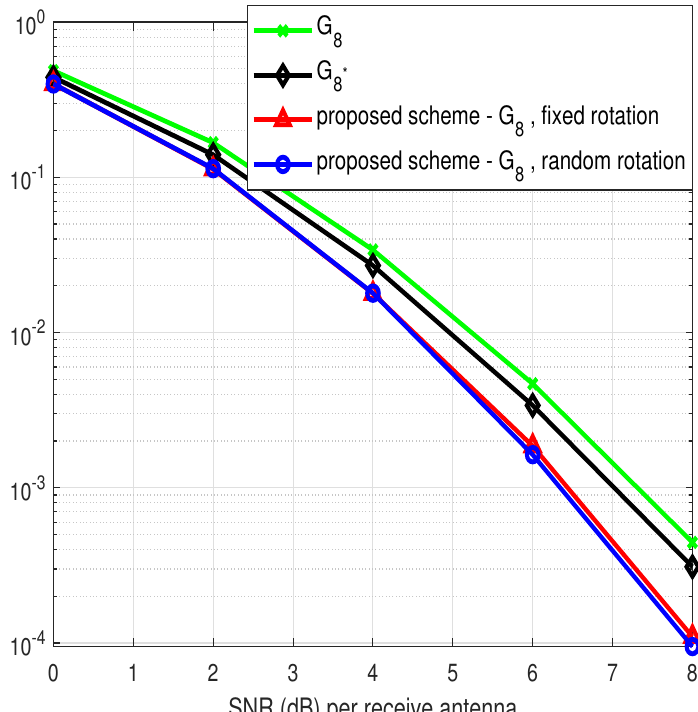
Figure 8. Performance of the proposed scheme based on BPSK − modulated STTC, M T = 2, M R = 2, L = M =